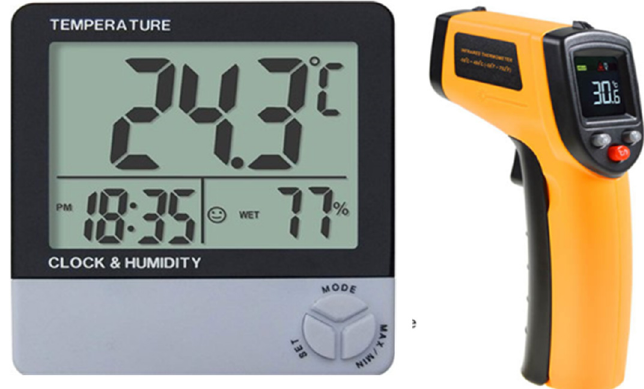
Figure 4. Sensors and data loggers used for the purpose of data collection.